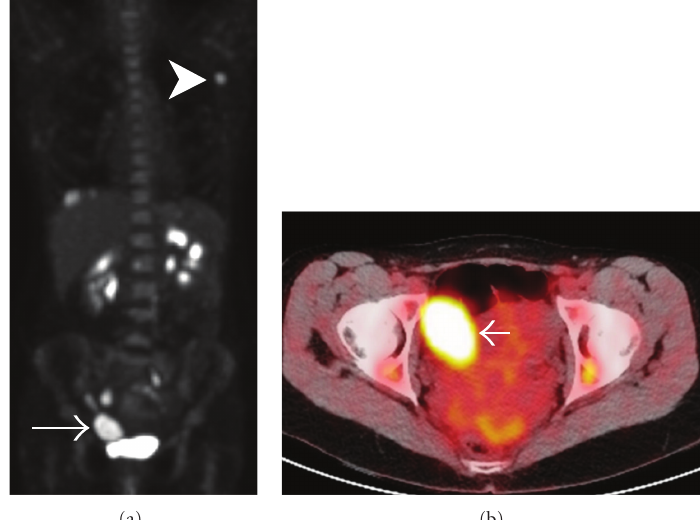
Figure 2: (a) Coronal maximum-intensity projection PET image shows abnormally increased FDG uptake within the left axillary lymph node (arrowhead) and within the right side of the pelvis (arrow). (b) Axial fused PET-CT image shows FDG-avid mass within the right adnexa of the pelvis, separate from the bladder (arrow).